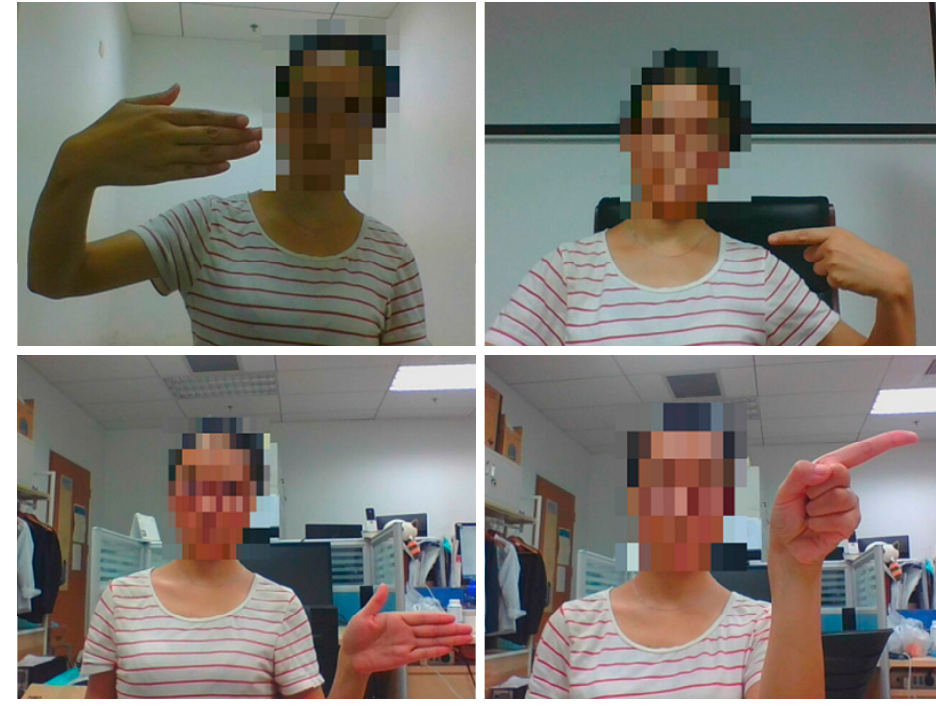
Figure 19. Results of the integration of deictic hand posture and spoken instructions when the demonstrative word was an adjective.